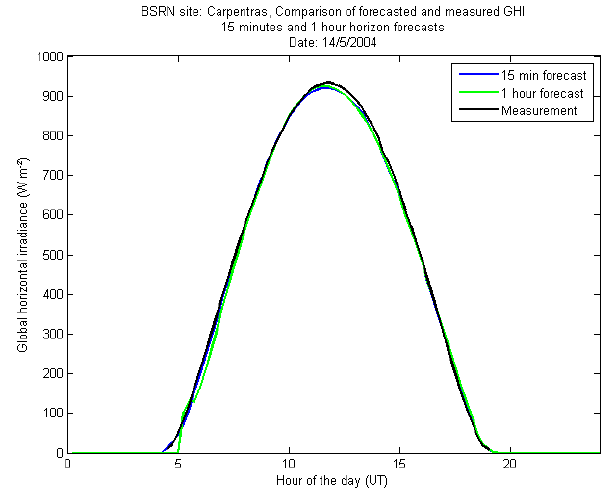
Figure 3. Daily profiles of 15min GHI values of the measurements (black line), the 15min ahead forecasts (blue line) and 1h ahead forecast (green line) at Carpentras for 27 March 2007.